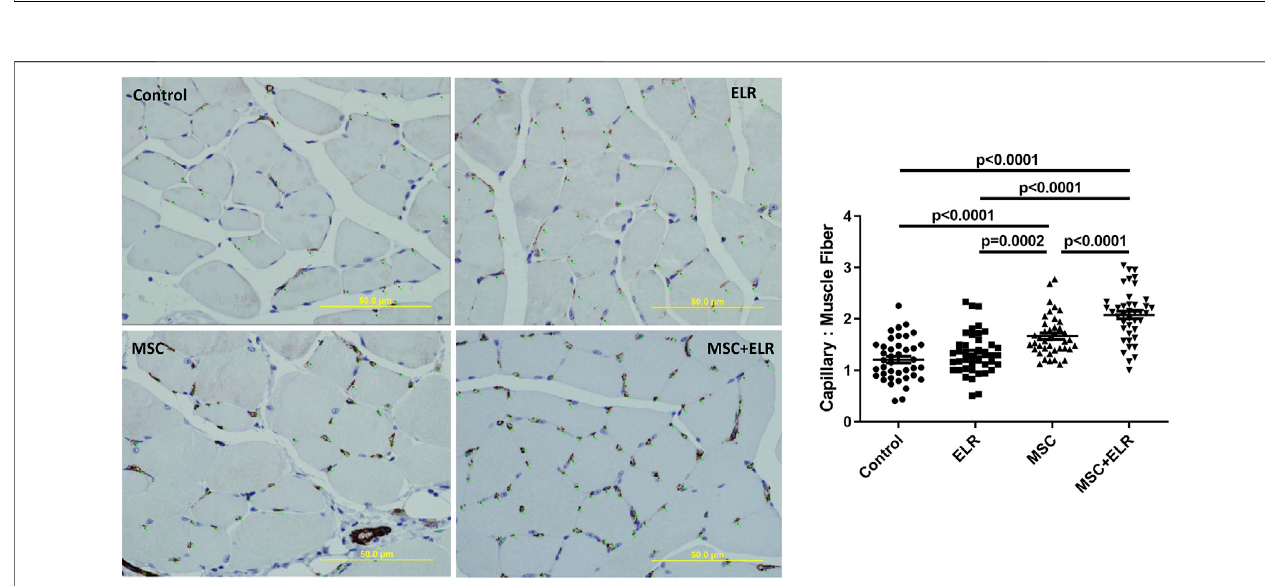
FIGURE 6 | Vessel quanti fi cation in ischemic muscles 21 days after treatment with the ELR biomaterial, MSCs, or both in CD1 mice. Vessel density was quanti fi ed by immunostaining of ischemic muscles using CD31 antibody. Vascularization was determined by the density of CD31 positively stained vessels, quanti fi ed as the number of capillaries per muscle fi ber. CD31 positive cells could be seen in brown due to DAB precipitation. Ten fi elds per muscle were analyzed. Quanti fi cation was carried out in four mice per condition. ELR: elastin-like recombinamer; MSCs: mesenchymal stromal cells.